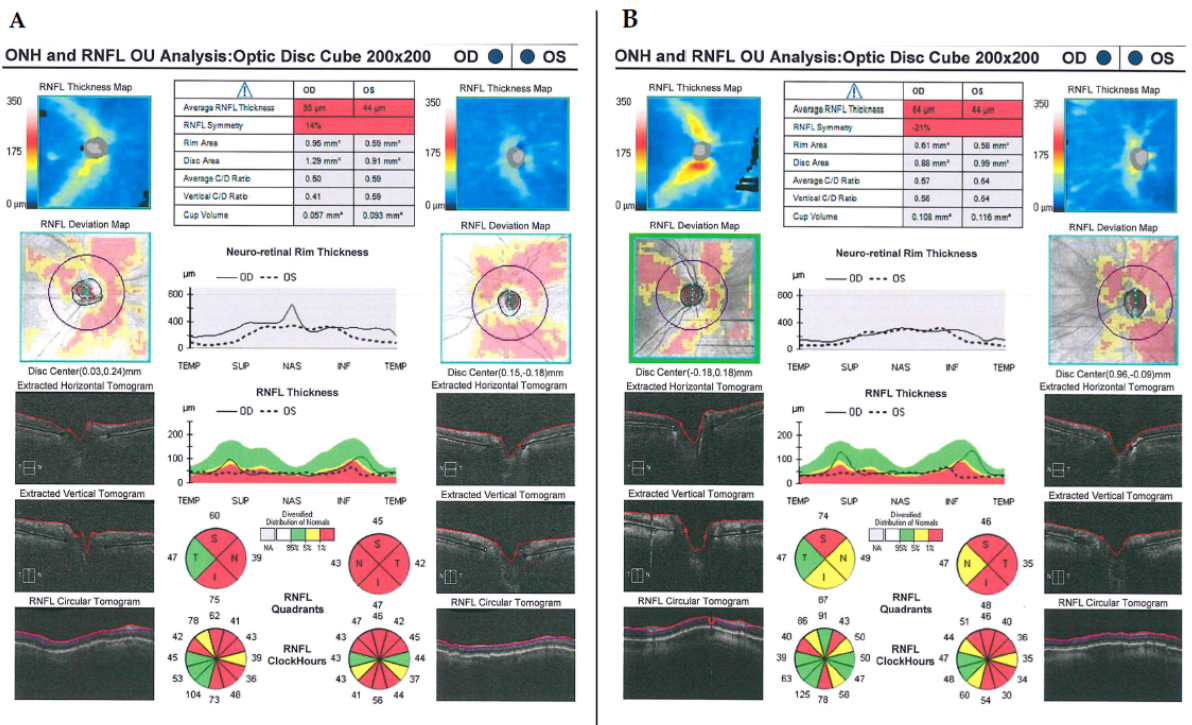
Figure 2. Example of the effect of the experimental light stimulation, as designed by the thermophysical approach. The patient is a 54-year-old man with glaucoma since he was 45, without any other pathology. The patient has been treated for 5 months, ten minutes per day everyday during any month, for each eye. The optical tomography of a patient before the treatment ( A ) and after the treatment ( B ). It is possible to highlight an improvement in the Nerve Fibre Layer. OS means Left Eye. OD means Right Eye. The colour scheme in the OCT is defined as follows: green colour code represents normality, yellow represents the suffering state and red represents the damaged state. The OCT system used has been the Zeiss CIRRUS